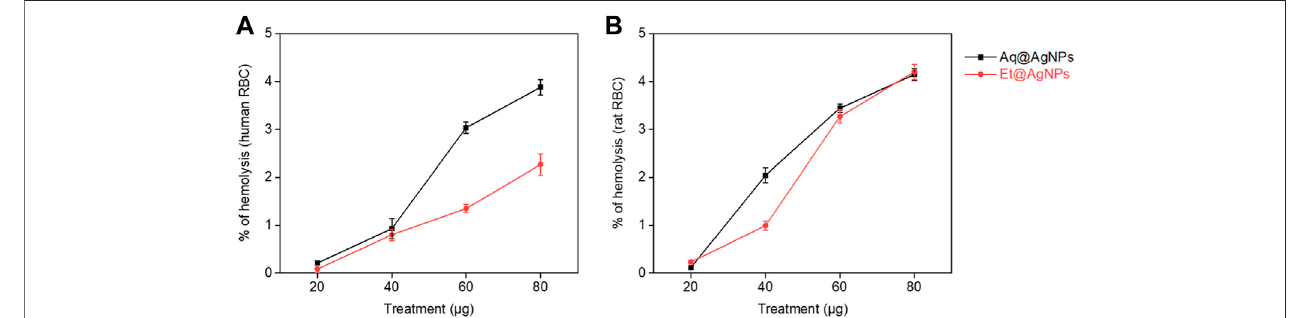
FIGURE 5 | Hemocompatibility of Aq@AgNPs and Et@AgNPs (A) human and (B) rat erythrocytes.